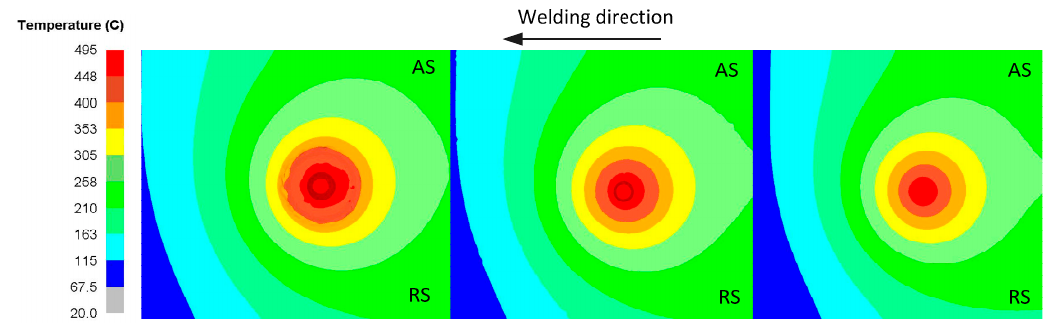
Figure 9. Temperature distribution of different thickness layers of the joint.